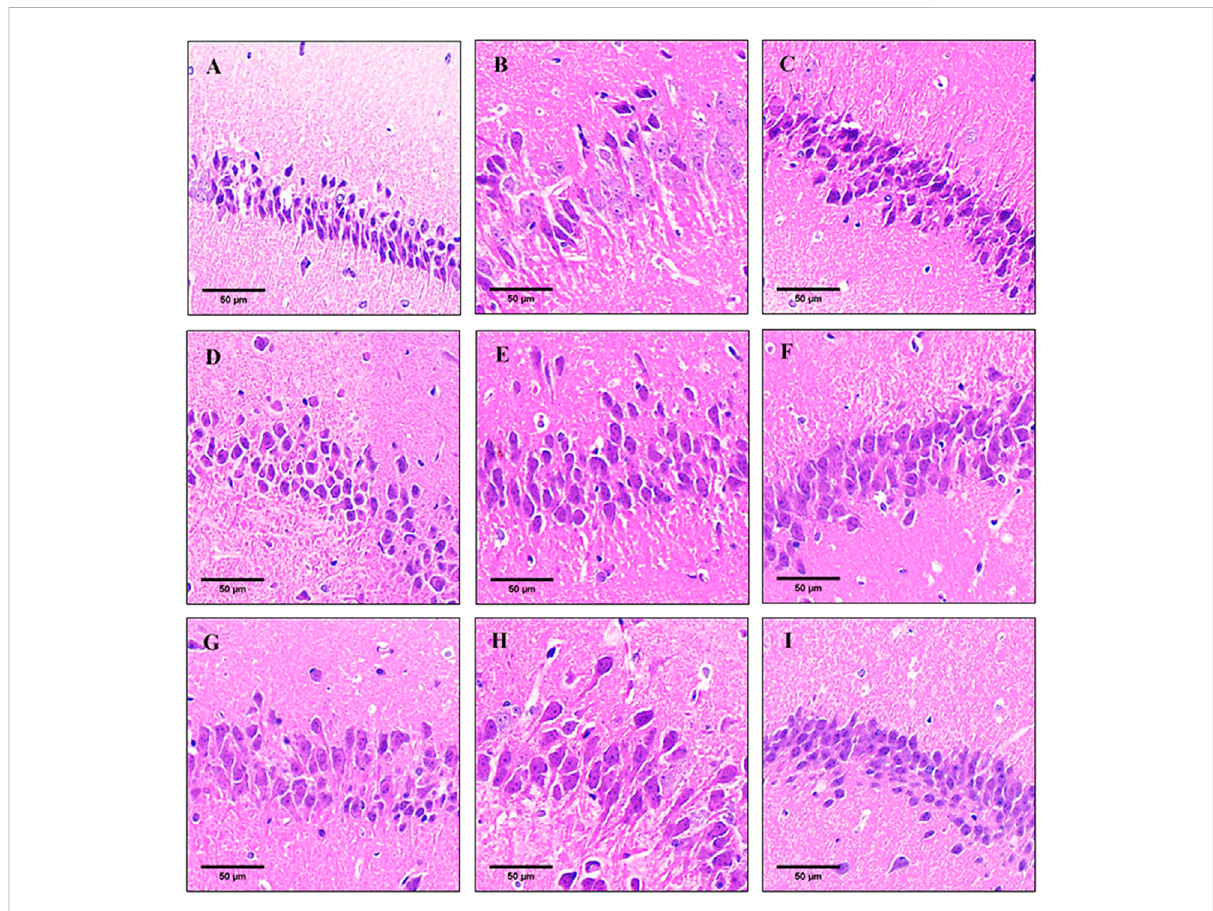
FIGURE 3 Pathological observation in hippocampal tissues of mice in each group (HE staining). (A) Control group; (B) model group; (C) donepezil group; (D) oil-L group; (E) oil-M group; (F) oil-H group; (G) thymol-L group; (H) thymol-M group; (I) thymol-H group. The scale is 50 μ